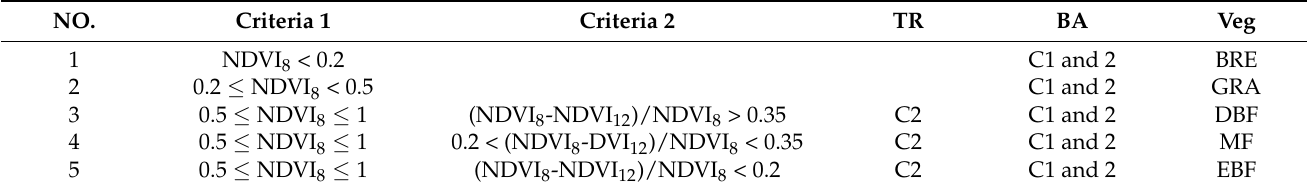
Table 1. NDVI for identifying vegetation type in land cover of tree and built